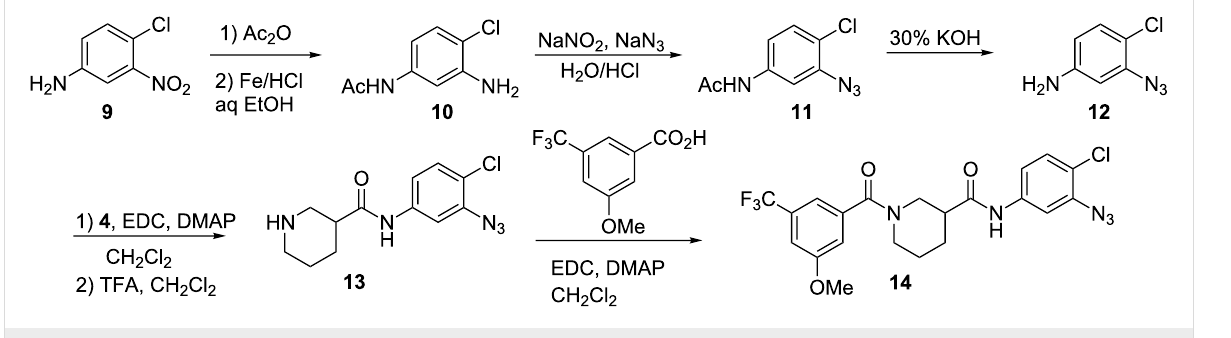
Scheme 2: Synthesis of aryl azide model probe 14 .